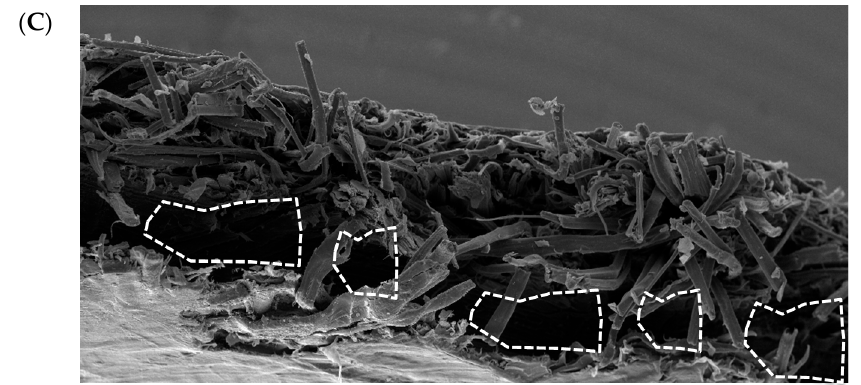
Figure 6. High-magnification SEM micrographs of fracture planes of laminated flax-PP fiber mats, under different exposure conditions following the 28-day incubation time period. The conditions included ( A ) no water-no fungi, ( B ) yes water-no fungi, and ( C ) yes water-yes fungi. In ( A ), there are observed regions of higher PP concentration on the outer faces of the sample. In the case of ( B ), there are some instances of fiber pull-out, as indicated by the more local bunching of the fibers and larger relative gaps between the bunches. For the condition ( C ), fiber pull-out appears to be much more prominent, with larger observable gaps, to the point where delamination between the outer PP-rich layer and inner fiber-rich layer has occurred (shown as hatched areas).